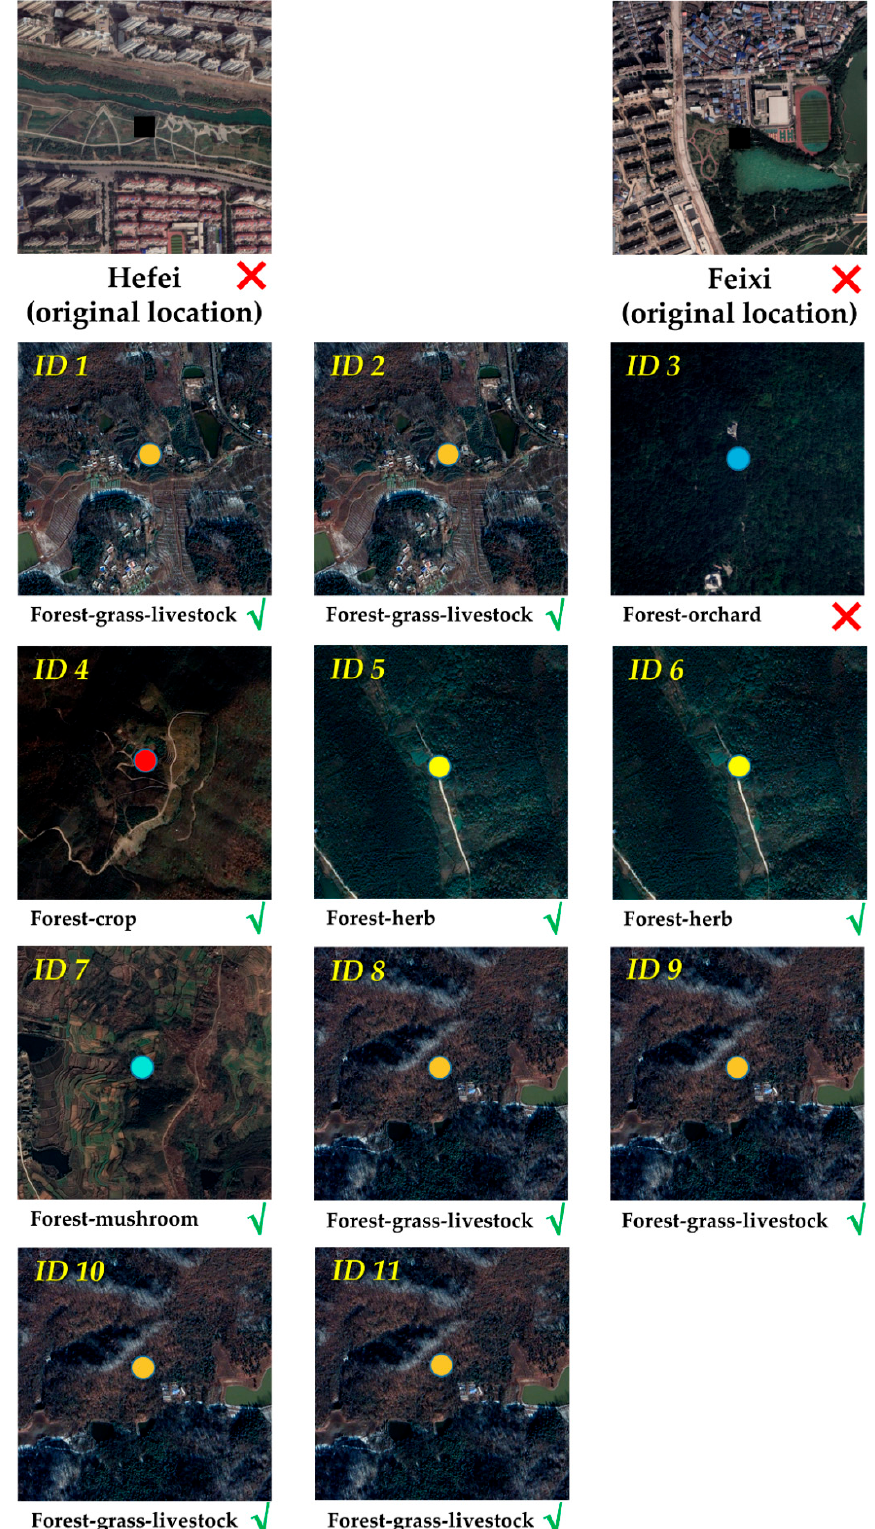
Figure A1. The enlarged corrected locations in Figure 7.